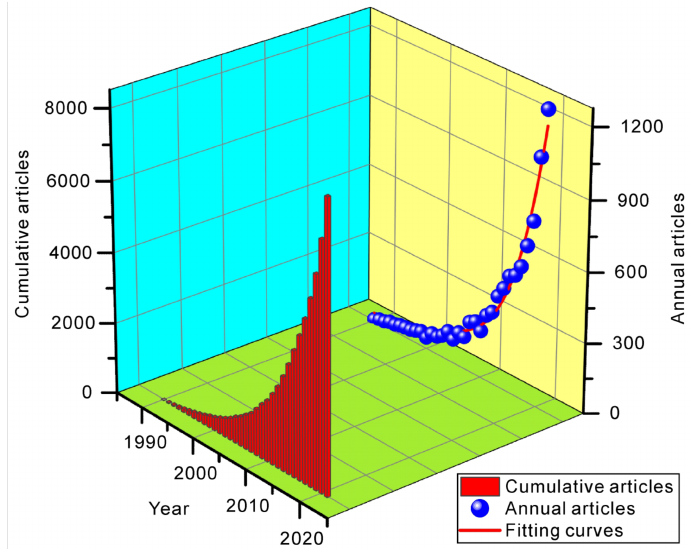
Figure 4. Characteristics of publications of AI for geohazard research by